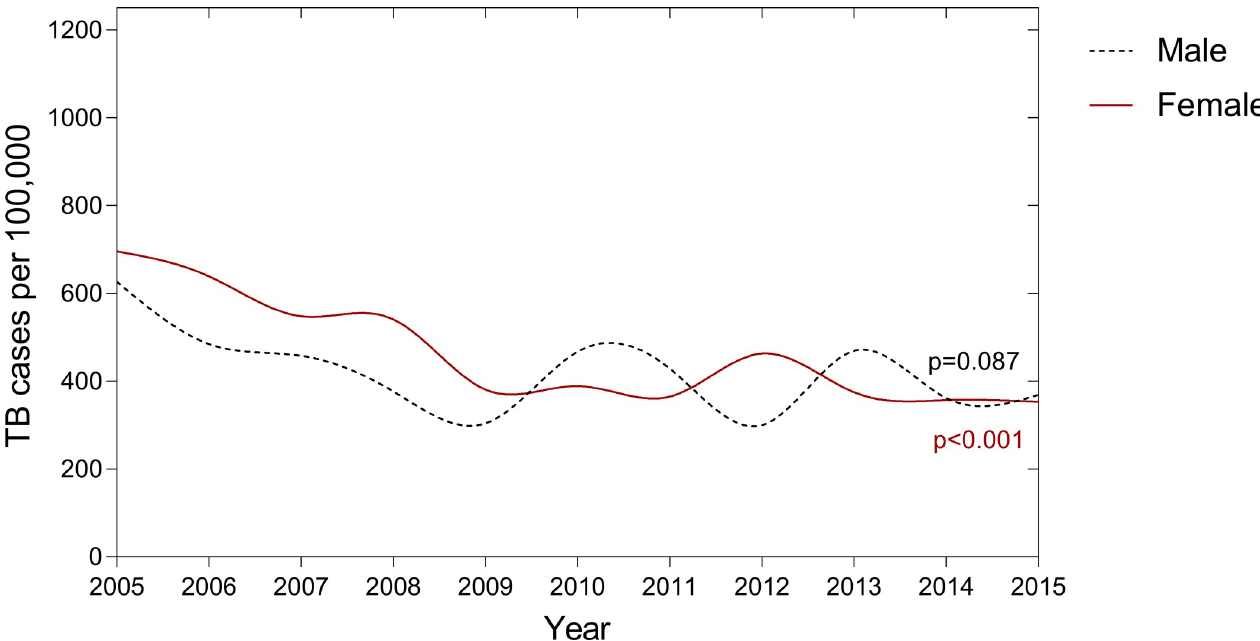
Fig 4. Adolescent TB temporal trends by sex. Legend: TB = Tuberculosis disease. Respectively among female and male adolescents, TB rates declined by 49% (from 696 to 353 patients per 100,000) and by 41% (from 627 to 369 patients per 100,000) from 2005 to 2015. P–value is for temporal trend between 2005 and